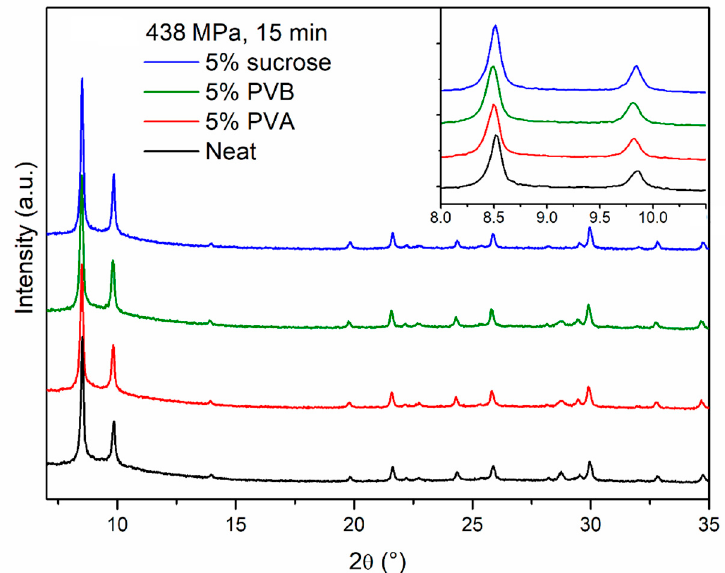
Figure 5. PXRD patterns of pellets prepared compressing neat MOF-801 (black), MOF-801 blended with 5% PVA (red), MOF-801 blended with 5% PVB (olive) and MOF-801 blended with 5% sucrose (blue) for 15 min under 438 MPa pressure. The inset shows the low angle region.